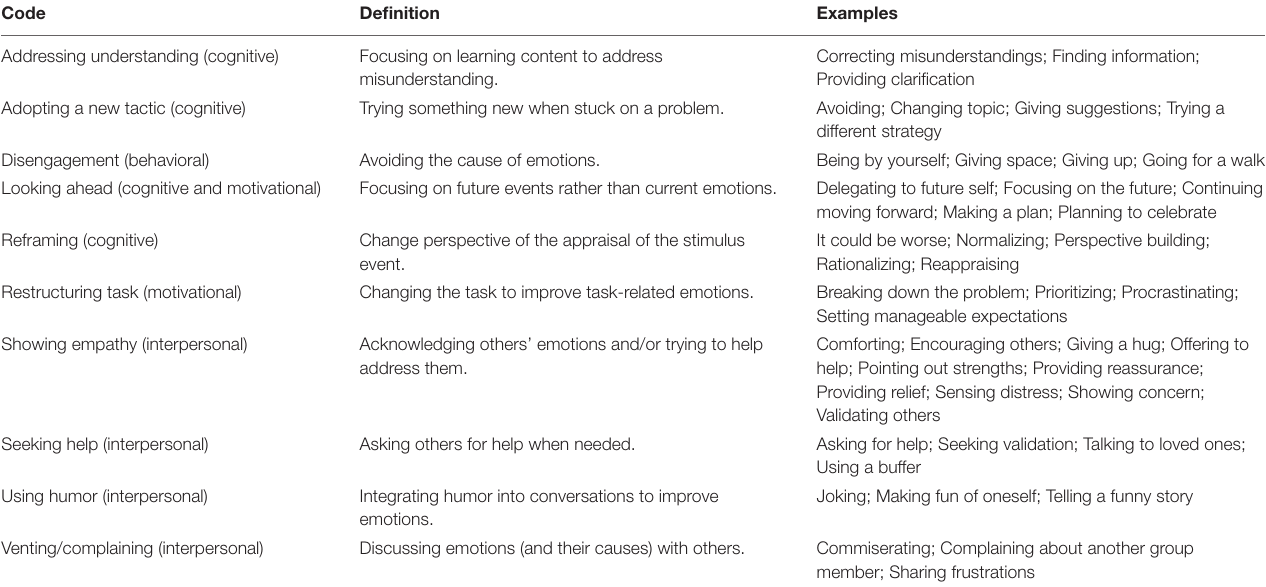
TABLE 8 | Regulation codes—strategies. Code Definition